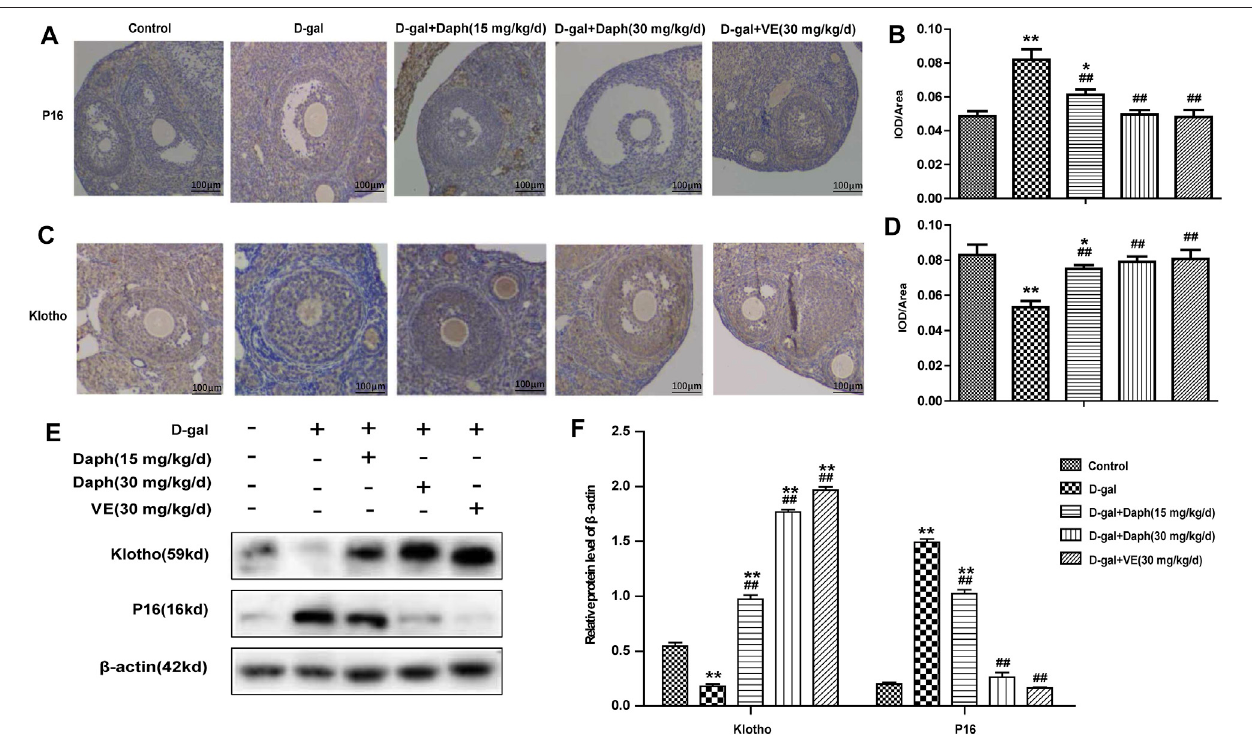
FIGURE 4 | Effects of Daph on p16 and klotho expression. (A,C) The IHC staining showed cellular locations of p16 and klotho proteins in different groups. (B,D) Thep16andklothoexpressionswerequantitativelyanalyzed. (E,F) Expressionsofp16andklothowereveri fi edbywesternblot.Thedatain (A – D) areshownasmeans± SEMs, n = 5. The data in (E – F) are shown as means ± SEMs, n = 3. Statistical signi fi cance: * p < 0.05, ** p < 0.01, ## p <